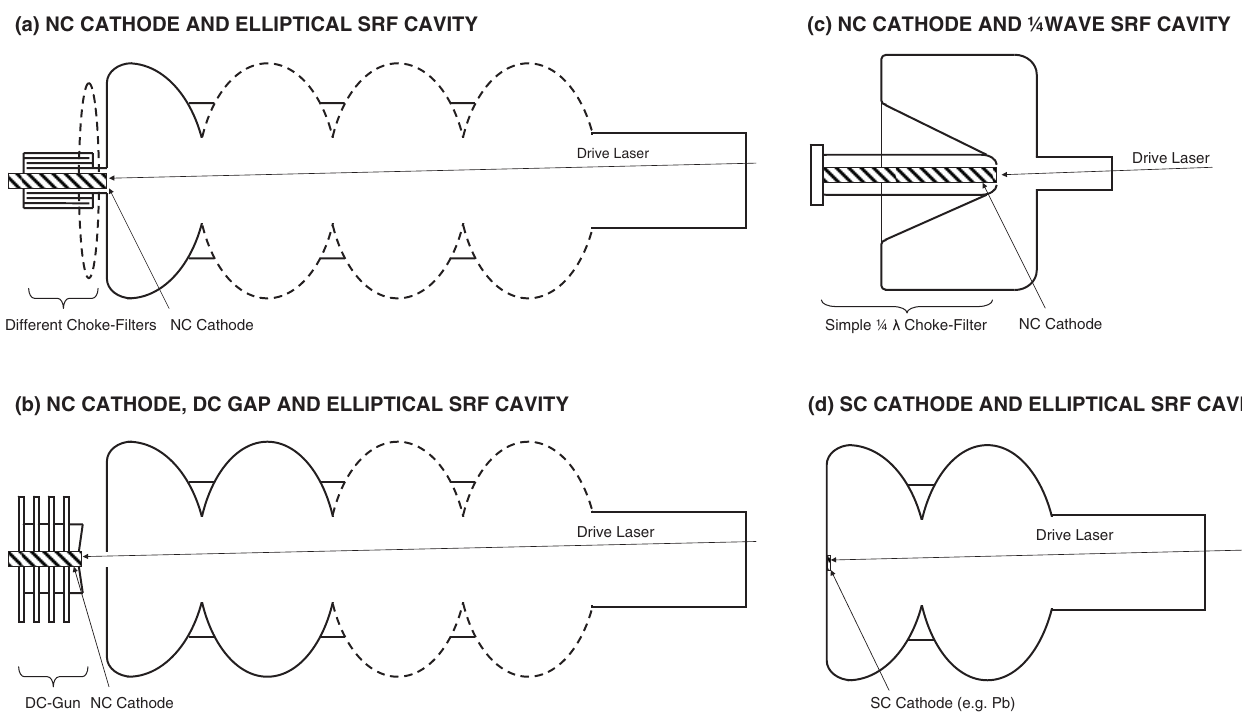
FIG. 1. Generic drawings of the proposed types of SRF guns; (a) NC cathode with either cavity (dotted) or quarter wave (solid) choke filter and 1–4 elliptical cells; (b) NC cathode with DC gap and 2–4 elliptical cells; (c) NC cathode with quarter wave cavity; (d) SC cathode with two elliptical cavity